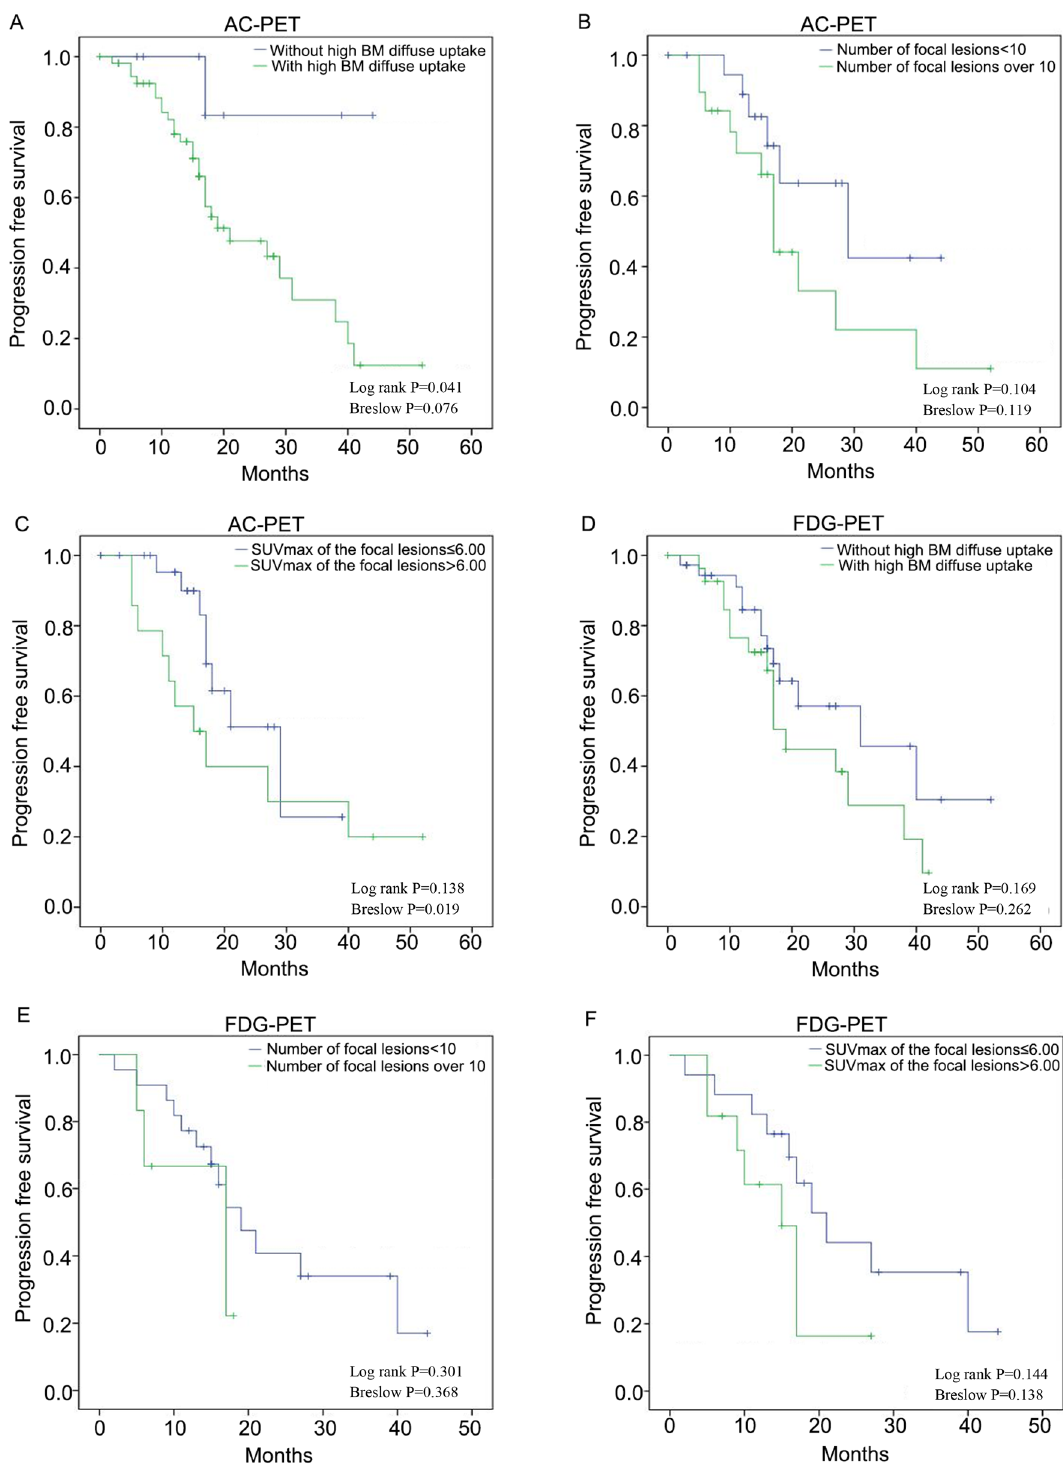
Figure 5. Kaplan–Meier survival analysis of PFS in AC-PET and FDG-PET. ( A , D ) Association between PFS and diffuse bone marrow uptake in AC-PET ( A ) and FDG-PET ( D ). ( B , E ) Correlation between PFS and the number of focal lesions in AC-PET ( B ) and FDG-PET ( E ). ( C , F ) Correlation between PFS and the SUV max of focal lesions in AC-PET ( C ) and FDG-PET ( F ). The log-rank test and Breslow test for Kaplan–Meier survival curves was applied for comparisons of